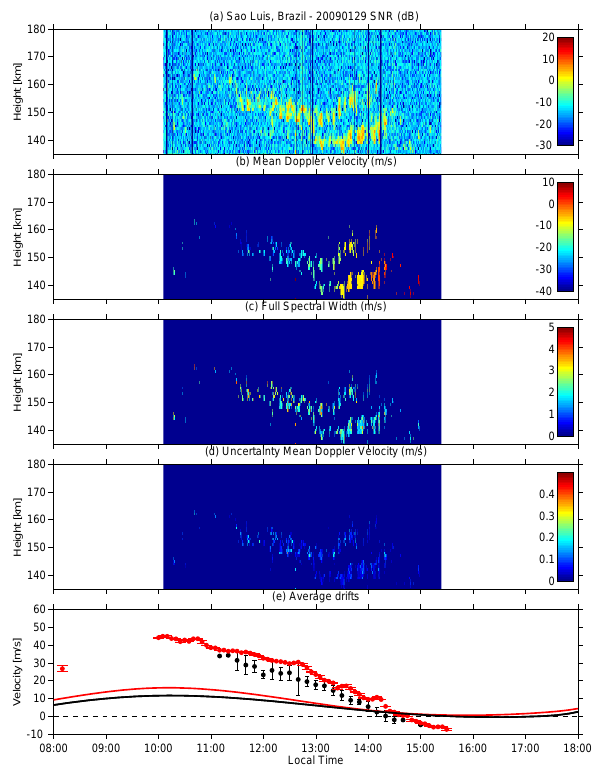
Fig. 6. Same as Fig. 2 but for 29 January 2009. The mean Doppler velocity of the 150km echoes measured by the Jicamarca radar is also show in (e) as red markers. The 3h Kp indices for this day are Fig.6. SameasFigure2butforJanuary 29,2009. ThemeanDoppler velocityofthe150-km echoes measured bytheJicamarca radarisalso 0, 2, 2 + , 1 + , 1 + , 0 + , 0 + , show in panel (e) as red markers. The 3-hour Kp indices for this day are: 0, 2,2+, 1+, 1+, 0+, 0+, 0.